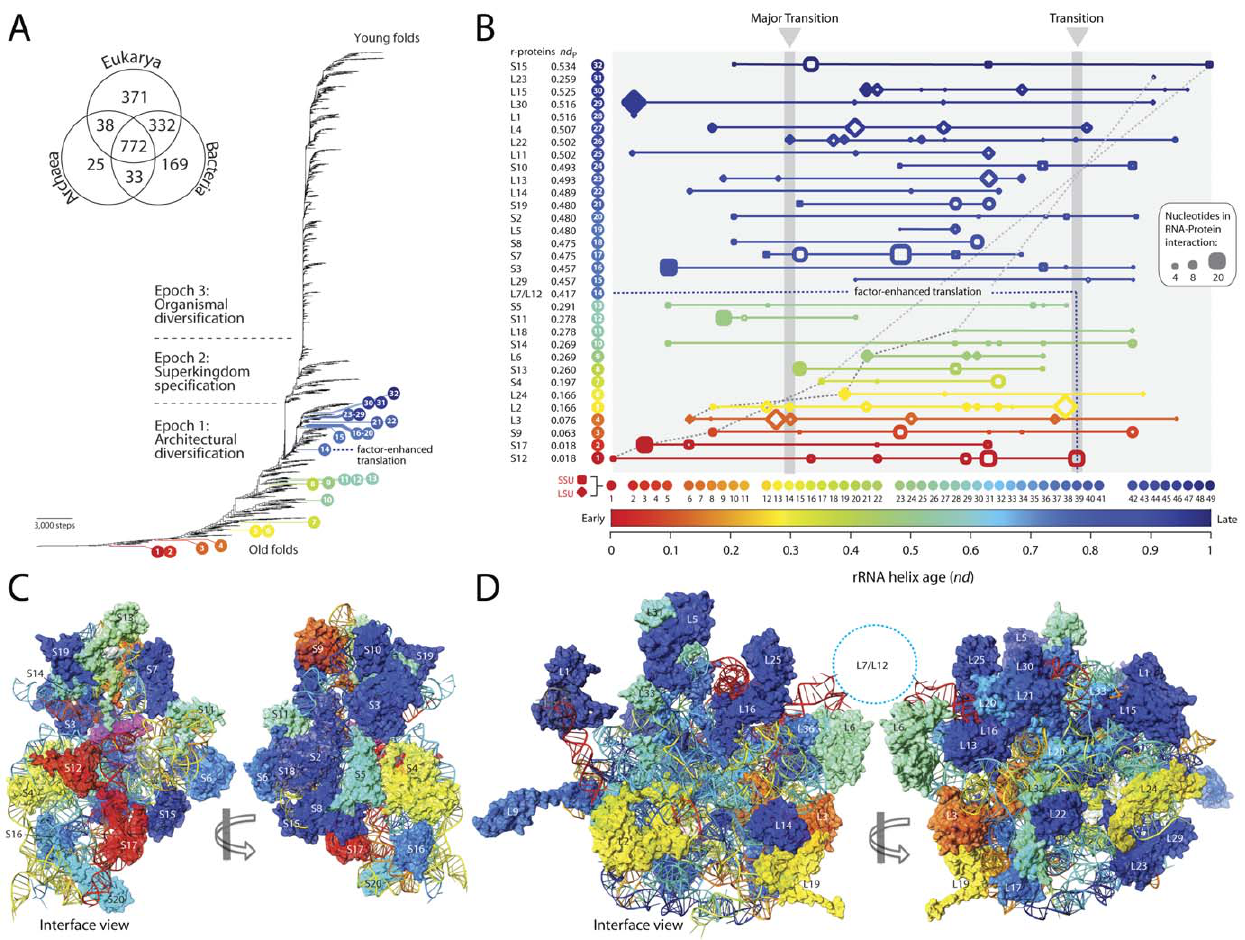
Figure 5. Relative age of r-proteins and their interaction with rRNA helices. A , Backbone of universal tree describing the evolution of 1,730 FSF domain structures from 749 genomes (541,383 steps; CI=0.028, RI=0.783; g1= 2 0.111). The Venn diagram shows occurrence of FSFs in the three superkingdoms. B , rRNA helices establishing contacts with universal r-proteins. The relative age of the rRNA helices ( nd ) increases from left to right and r-proteins are ordered by age (from bottom to top) with corresponding nd P value. The number of nucleotides at each time point involved in RNA-protein interactions is proportional to the size of squares (SSU) and rhomboids (LSU). r-proteins contacts are colored according to the age of the helix that makes the most ancient contact or is inferred from Figure S2. C , Evolutionary heat map of SSU r-proteins. D , Evolutionary heat map of LSU r-proteins. The 3D structures show the relative age of the rRNA helices and the relative age of r-proteins interacting with them.